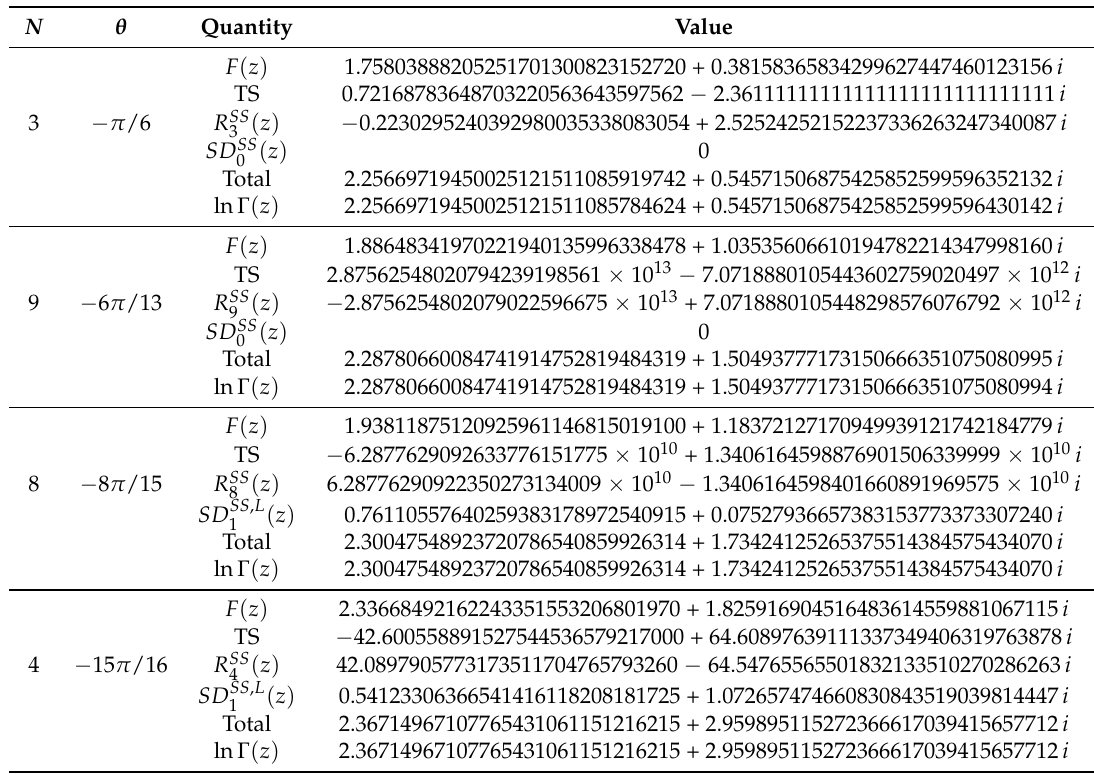
= 1/10 for various values of the truncation parameter, N , and arg z z | |